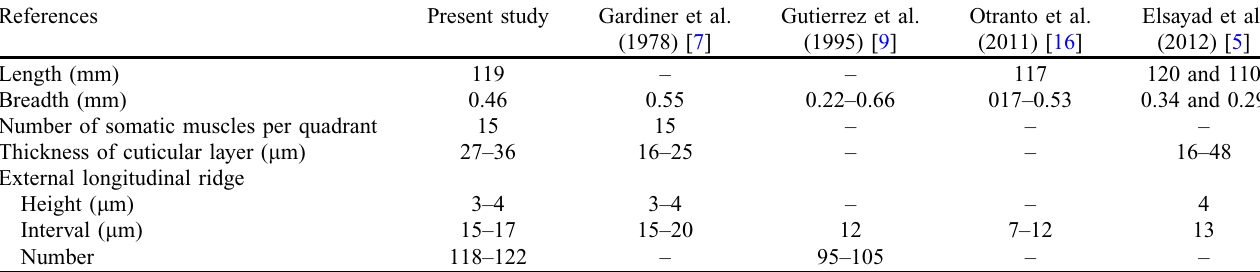
Table 2. Morphological aspects of female Dirofilaria repens in infected humans.